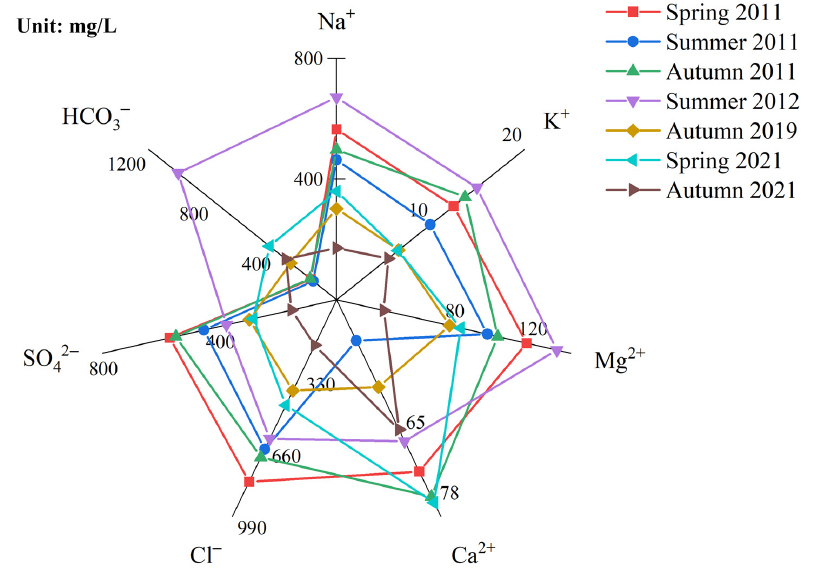
Figure 11. Interannual changes in the main ions of Wuliangsu Lake.